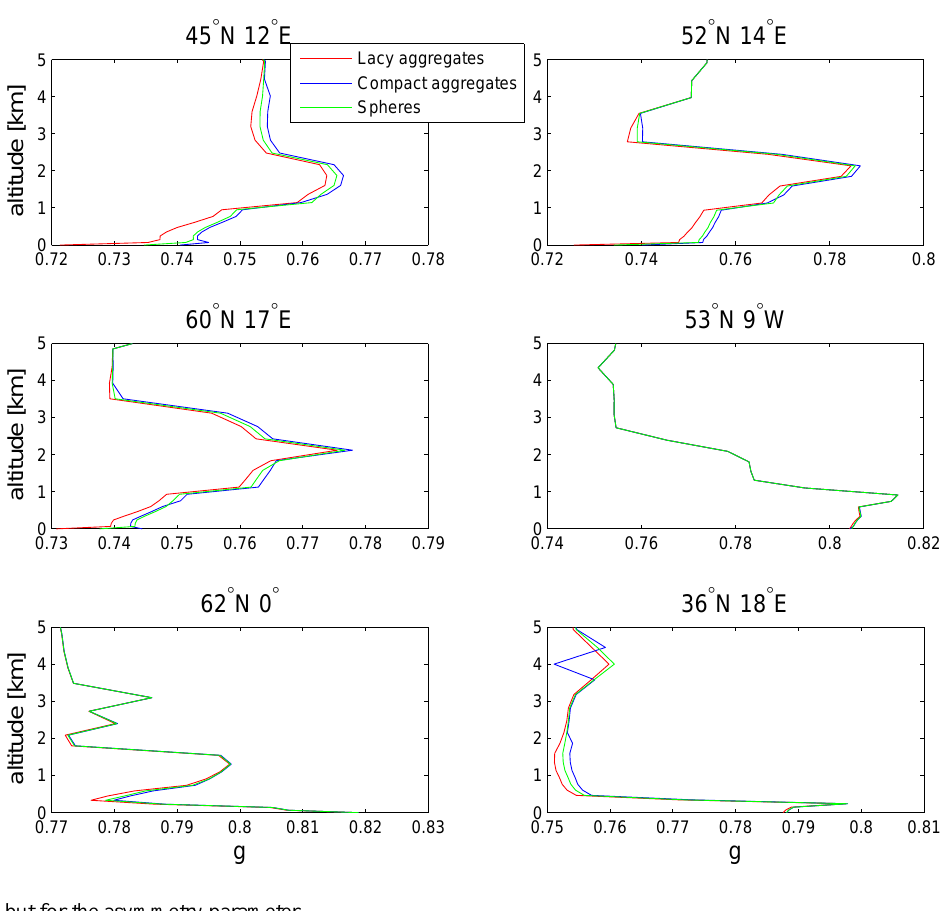
Fig. 6. As Fig. 4, but for the asymmetry parameter.